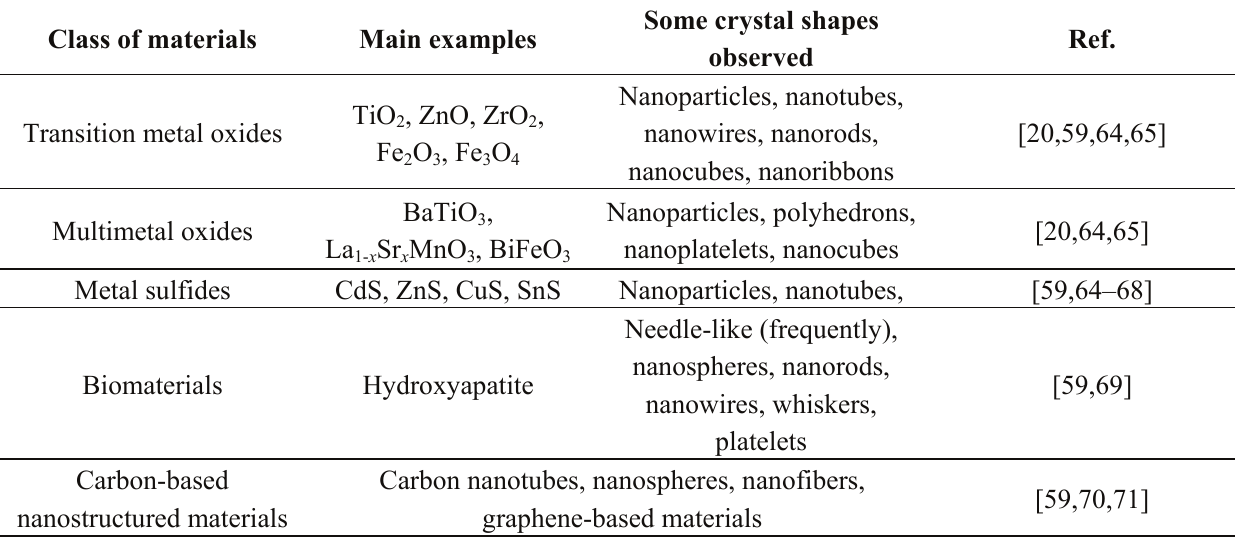
Table 1. Some of the different classes of materials synthesized by the hydrothermal